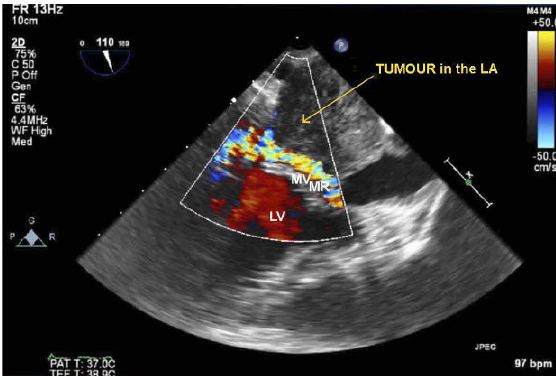
Figure 1. Two-dimensional trans-oesophageal echocardiography of the tumor in the left atrium (LA). LV, left ventricle; MV, mitral valve; MR, mitral regurgitation.